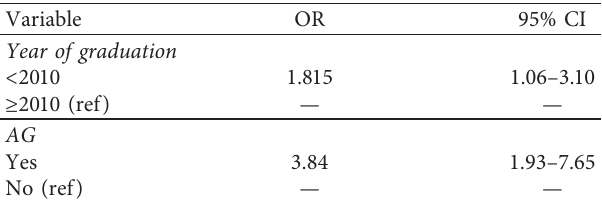
Table 3: Multivariate logistic regression predicting IOH practices ( N �